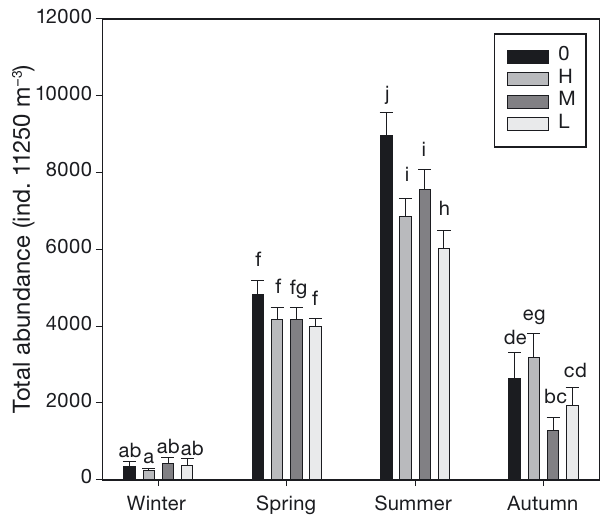
Fig. 1. Total abundance (mean ± SE) of wild fish (no. ind. 11250 m −3 ) aggregated around the studied fish farm at times of different feeding intensity within seasons. 0: non-feeding; H: high feeding intensity; M: medium feeding intensity; L: low feeding intensity. Different letters above bars indicate signifi- cant differences between the levels of the Season × Feeding intensity interaction (pairwise PERMANOVA, p < 0.05)